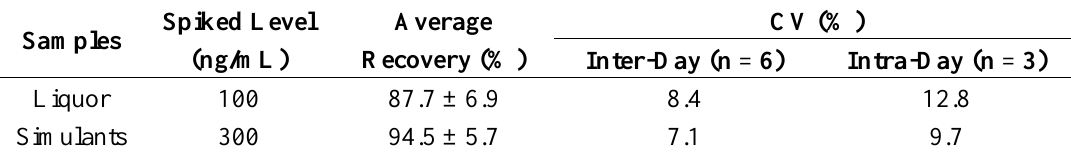
Table 2. Recovery results for fortified liquor simulant.